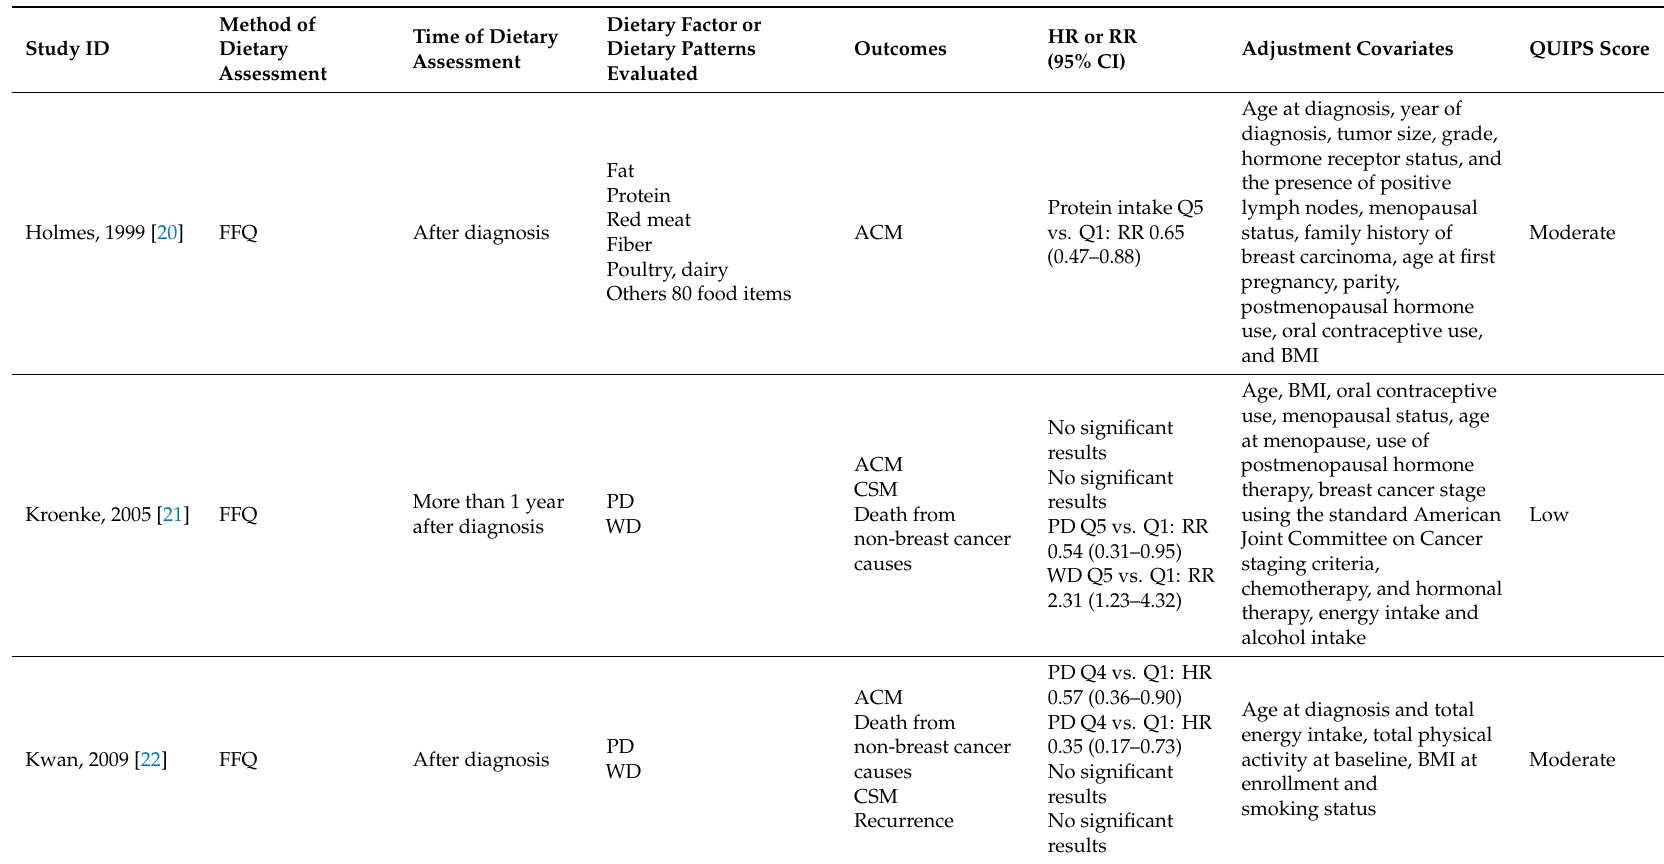
Table 2. Summary of results of the included studies enrolling patients diagnosed with breast cancer. Statistically significant ( p < 0.05) results, HR or RR with 95% CI, are